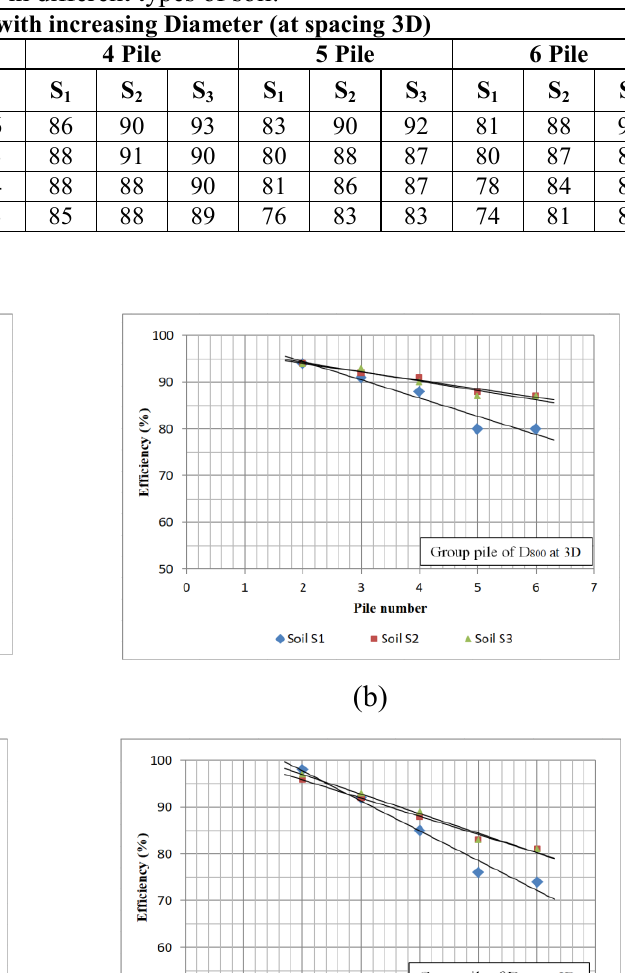
Efficiency of group piles at different diameters in different types of soil.